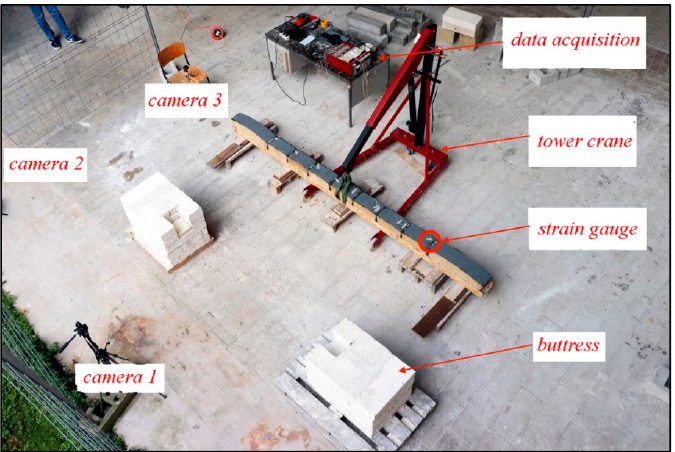
Figure 9. Prototype equipment.